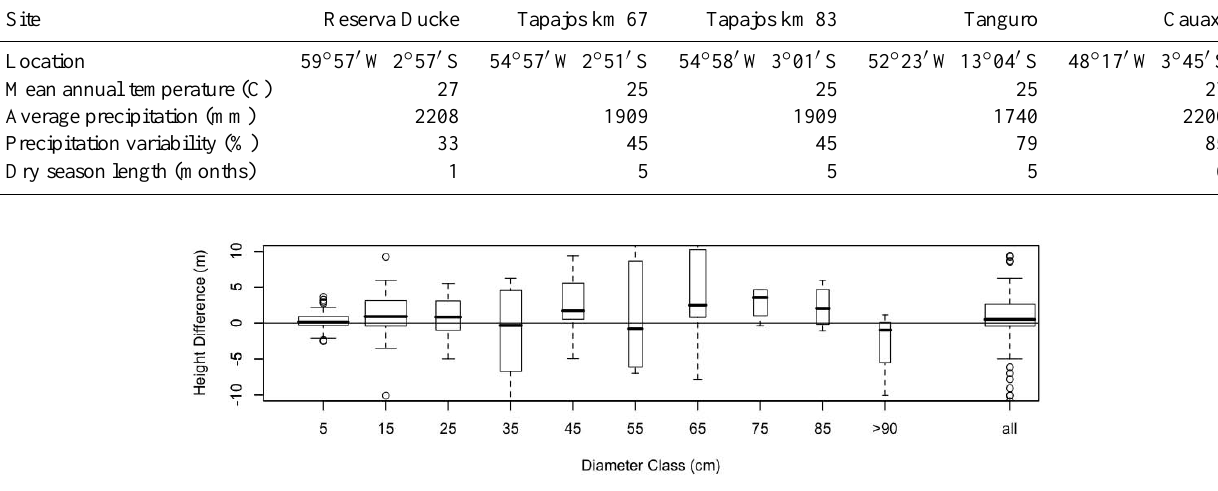
Fig. 2. Height measurements were repeated for 174 trees during the 2009 field campaign at Tapajos km 67. Box width is proportional to the square root of the sample size. The mean height difference for all remeasured trees is 1.1m, with a standard deviation of 4.7m.